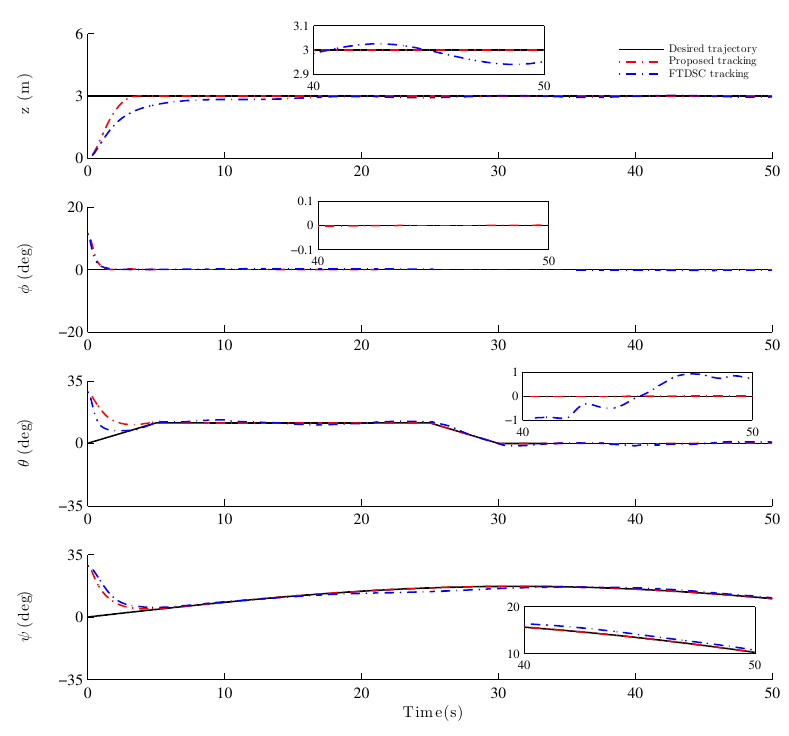
Figure 2. Time response of trajectory/attitude tracking.